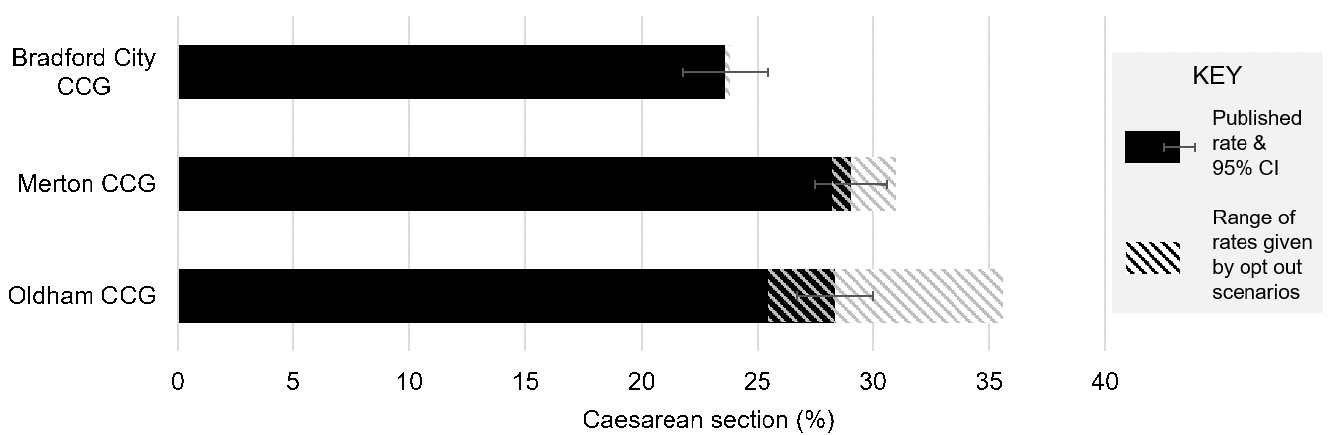
Figure 2: Observed and simulated rates of deliveries by caesarean section: By CCG, 2016/17 [21, 25]